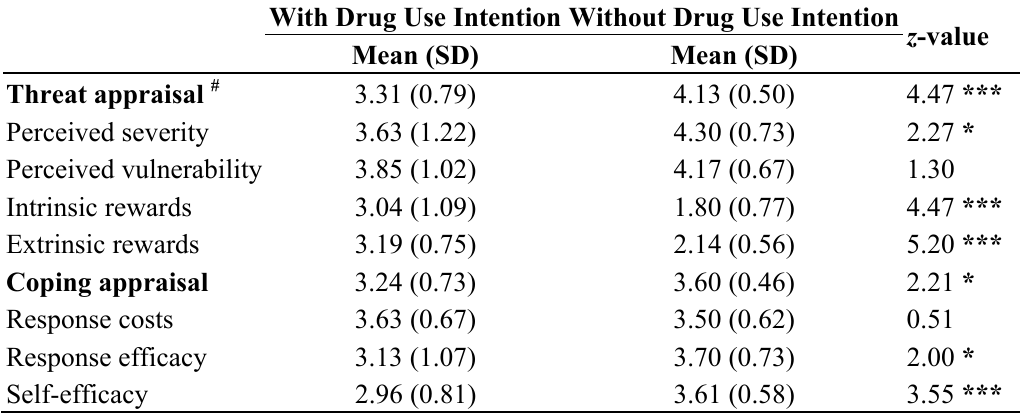
Table 2. PMT Measures and Drug Use Intention (N = 318).